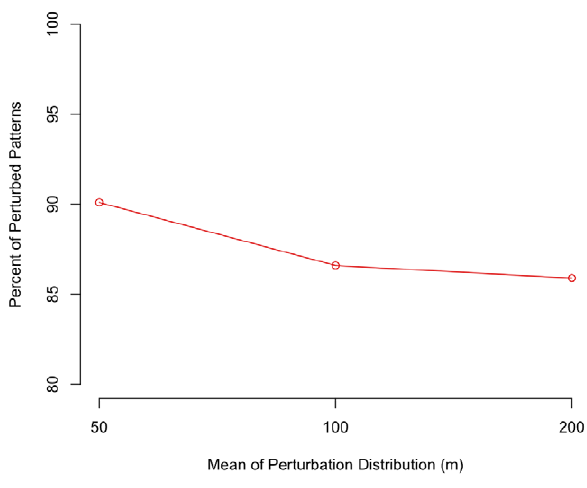
Figure 12. Percentage of patterns where the original MLC was reported as the MLC across the different perturbation levels.